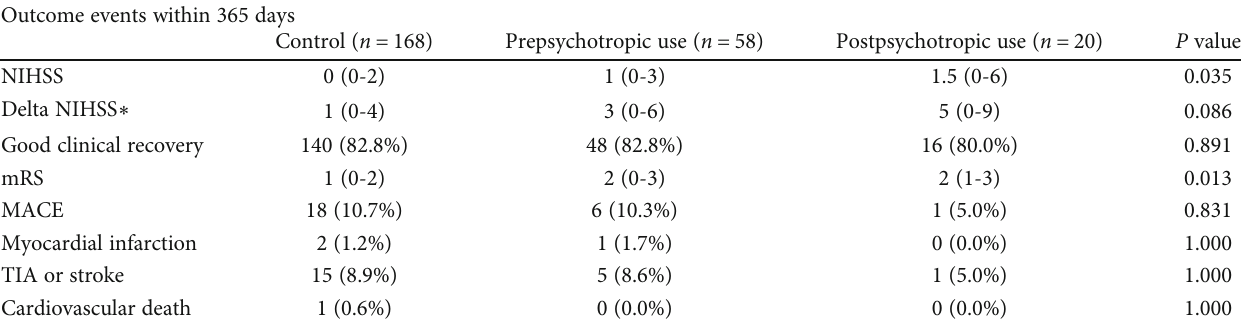
Table 3: Outcome events within 365 days from the initial ischemic